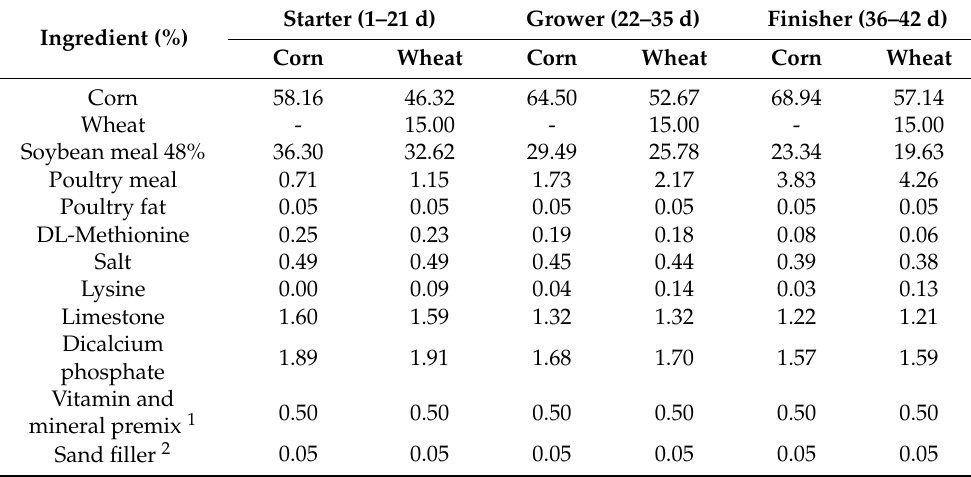
Table 1. Composition and nutrient content of experimental